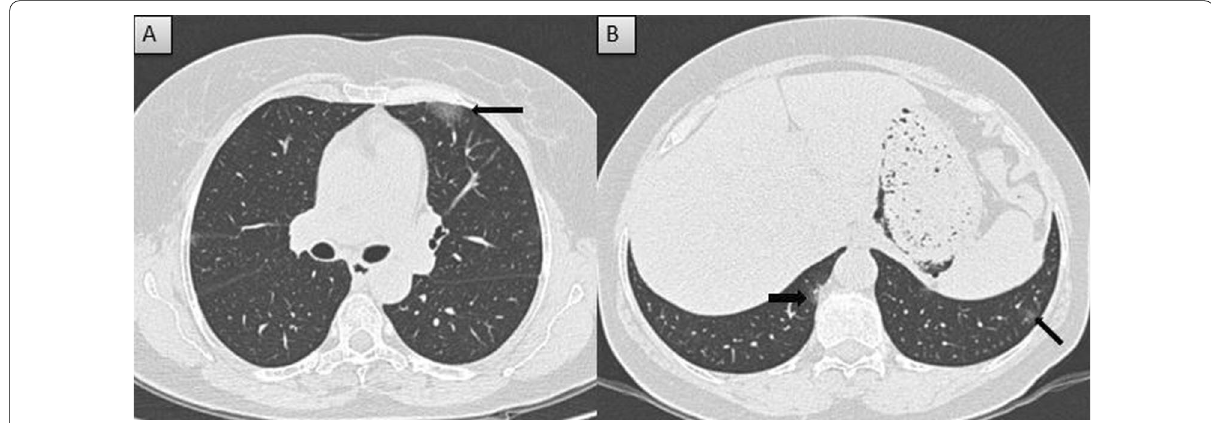
Fig. 3 Mild severity in completely vaccinated patient: A and B Axial CT thorax (lung window) of a 59-year-old COVID pneumonia patient who had received two doses of Covid vaccine shows patchy peripheral ground glass opacities with CT severity score of 3/25 (mild